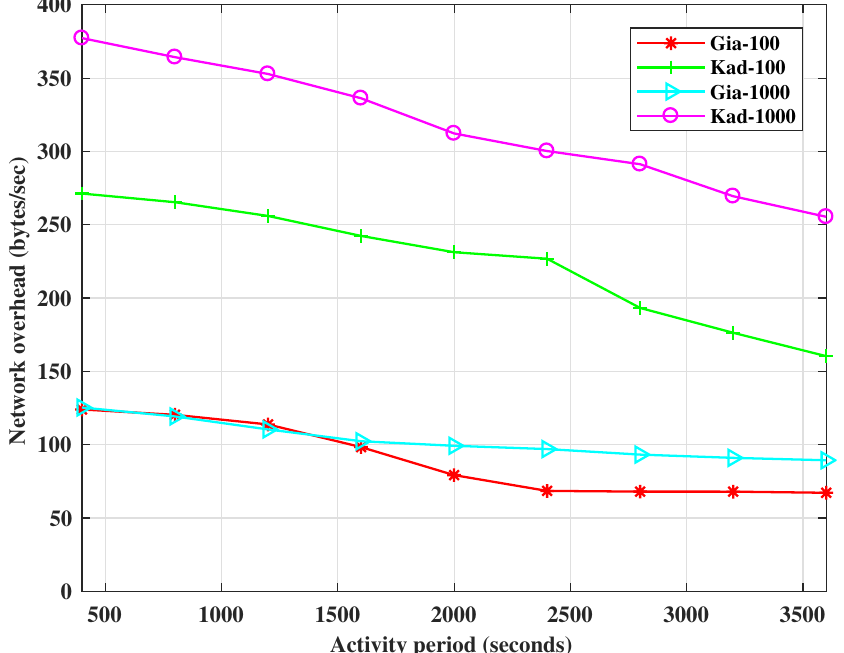
Figure 4. Performance comparison of total bandwidth cost of the network expended by Kademlia and Gia P2P protocols.